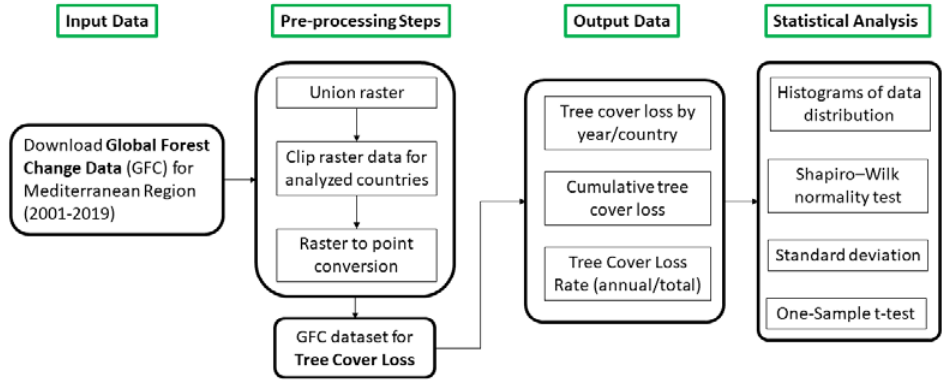
Figure 2. Flowchart including input data, pre-processing steps, statistical analysis, and output data to determine the tree cover loss in the Mediterranean Region. Table 1. Landsat-7 ETM+ geographical coordinates covering the study area (Data obtained from the Global Forest Change platform [45]).